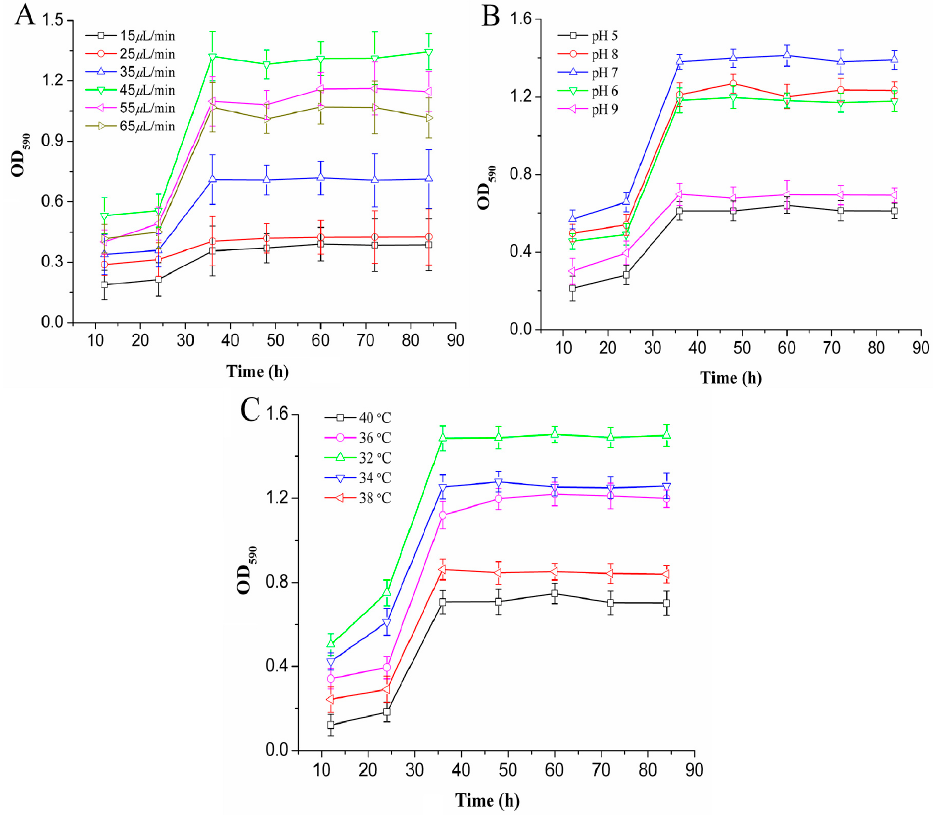
Figure 2. Effects of different flow rates ( A ), pH ( B ), and temperature ( C ) on the formation of recombinant E. coli BL21-pET28a- egfp biofilms. recombinant E. coli BL21-pET28a- egfp